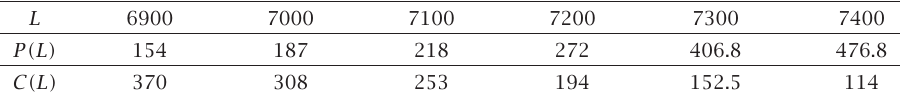
Table 3.1 . Put and call option prices for the SMI.